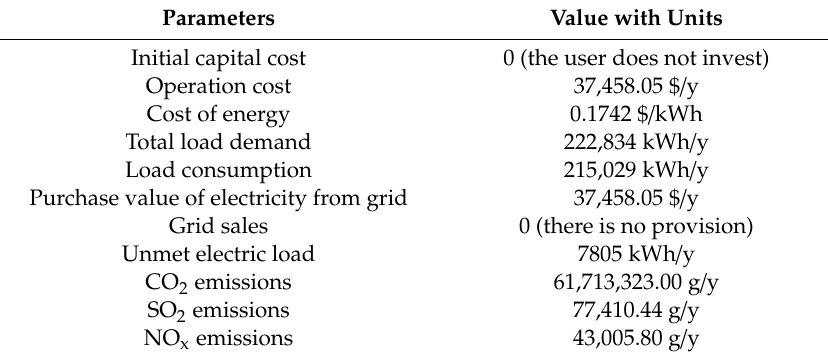
Table 5. Techno-economic and environmental indicators of a power supply system without any backup energy storage or generation facility.